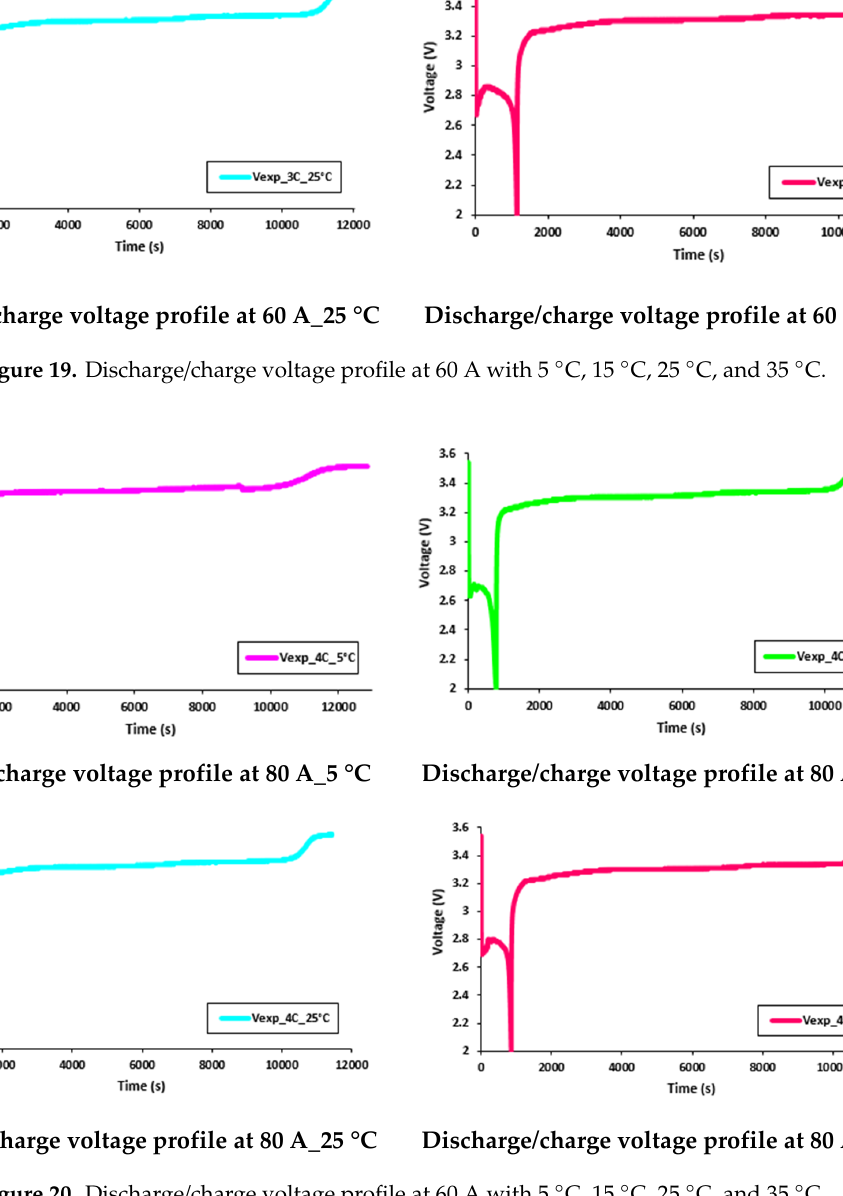
Figure 20. Discharge/charge voltage profile at 60 A with 5 °C, 15 °C, 25 °C, and 35 °C.